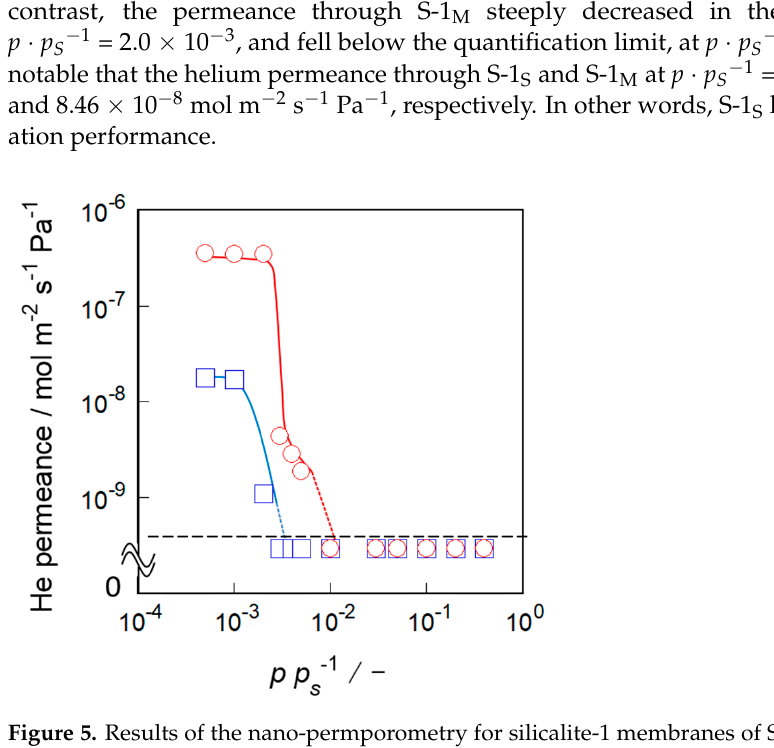
) and S-1 M ( (cid:3) ). (cid:35)